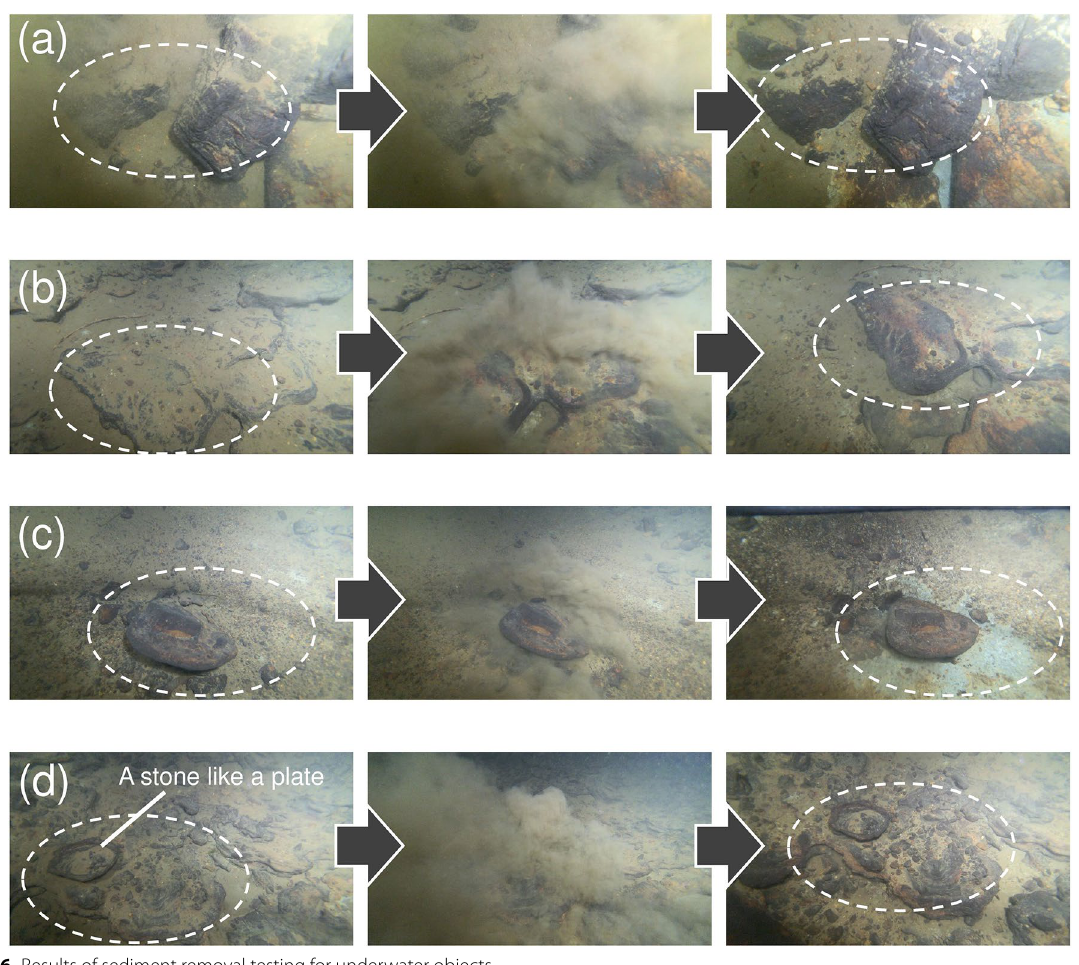
Fig. 16 Results of sediment removal testing for underwater objects